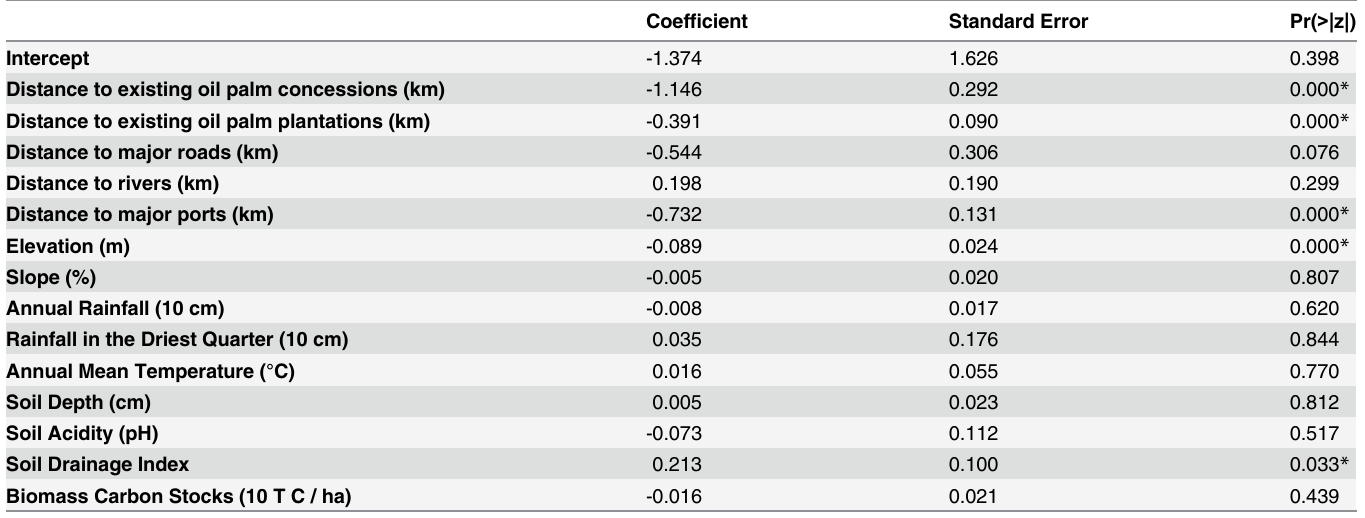
Table 1. Probability of oil palm plantation expansion: logistic regression